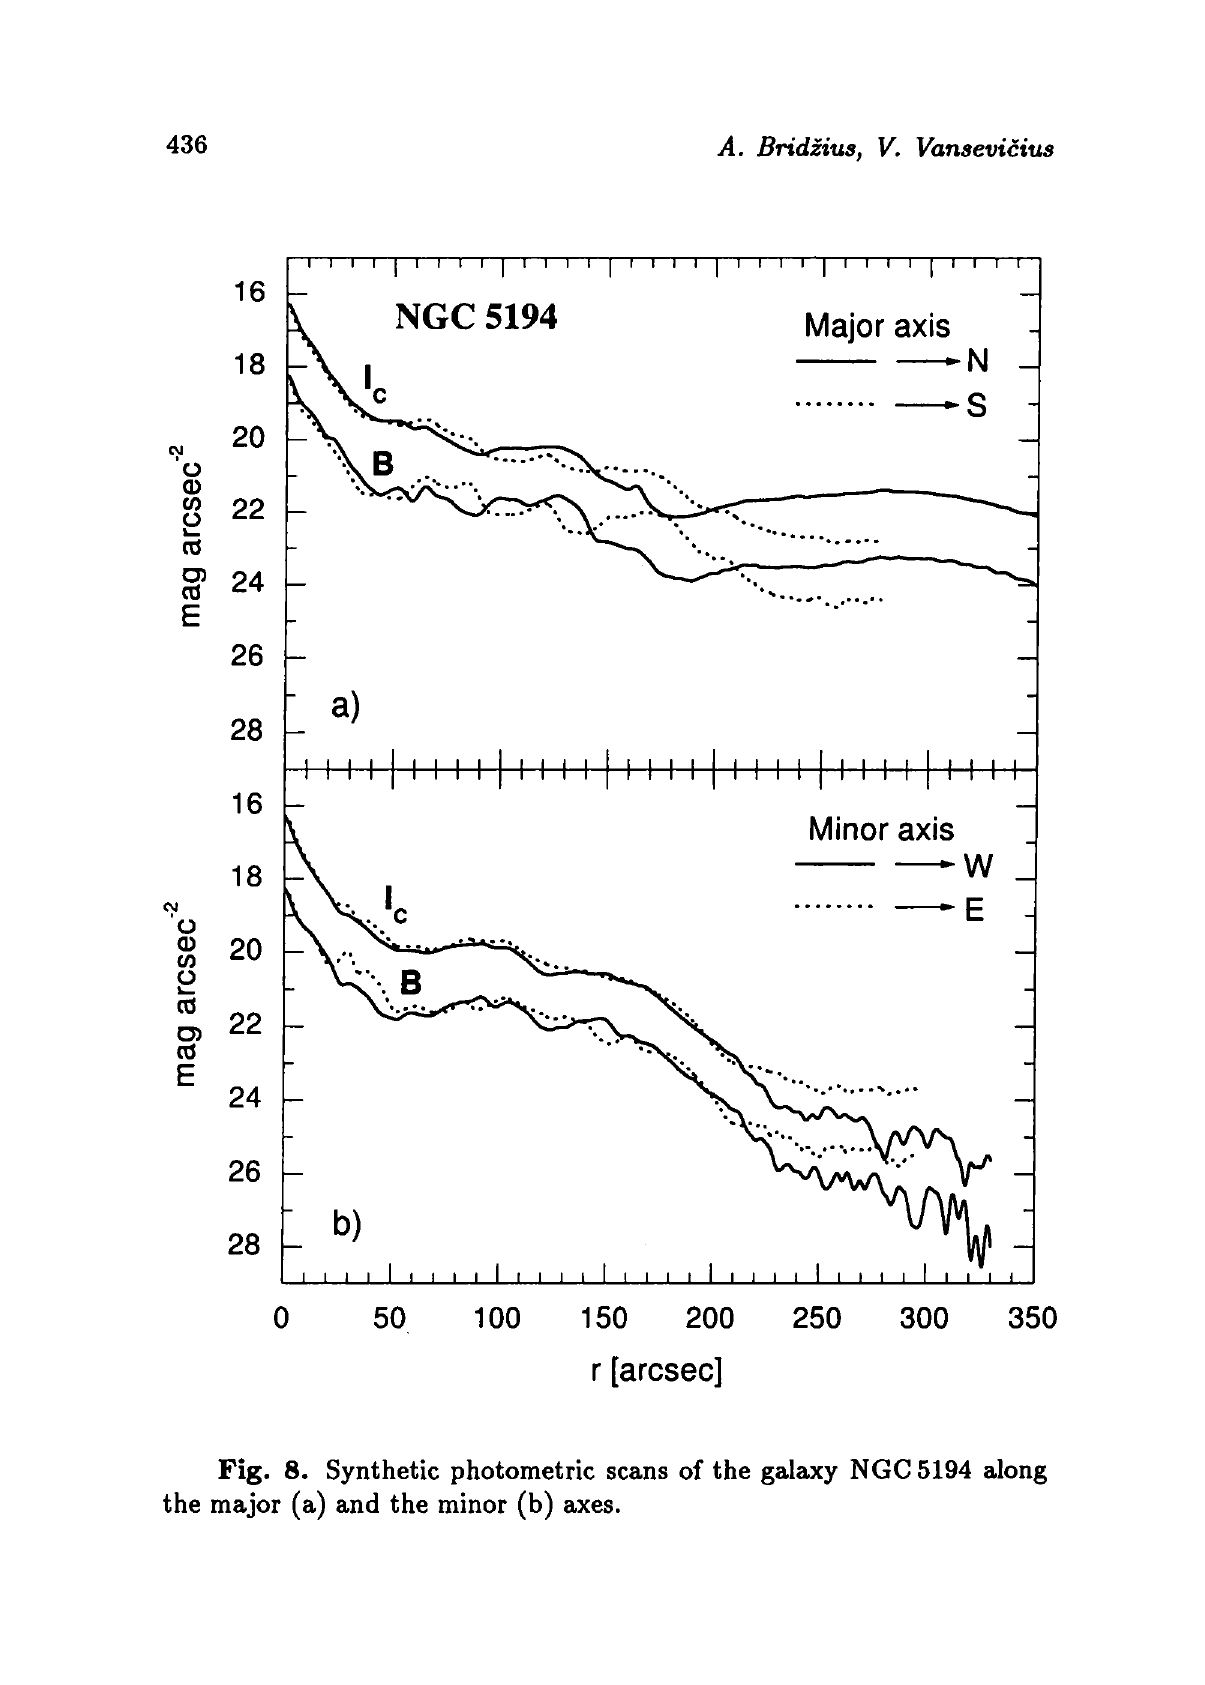
Fig. 8. Synthetic photometric scans of the galaxy NGC 5194 along the major (a) and the minor (b)